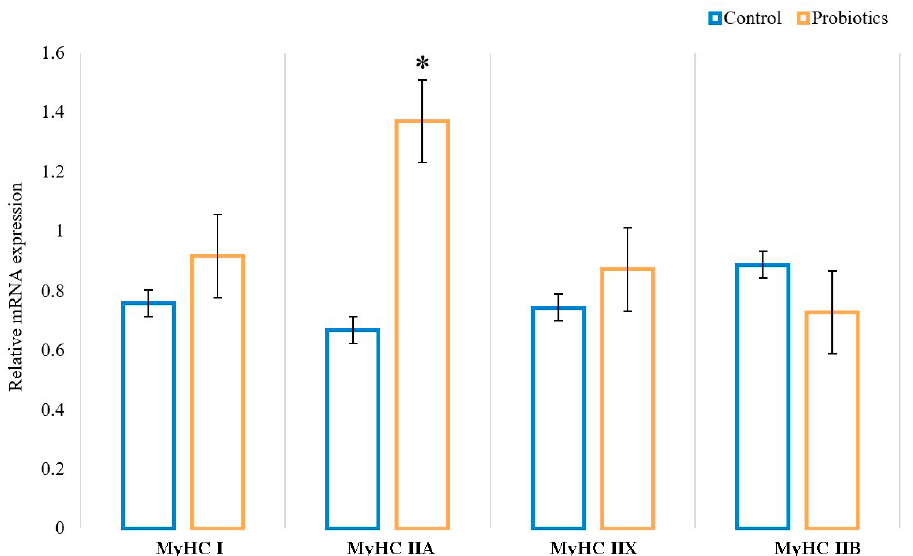
Figure 3. Effects of probiotics on the relative mRNA expression of myosin heavy chain (MyHC) isoforms (MyHC I, IIA, IIX, and IIB) in the muscle longissimus thoracis; 18S was used as an internal control. Data are expressed as means ± SE ( n = 6). * indicates a statistically significant difference ( p < 0.05).